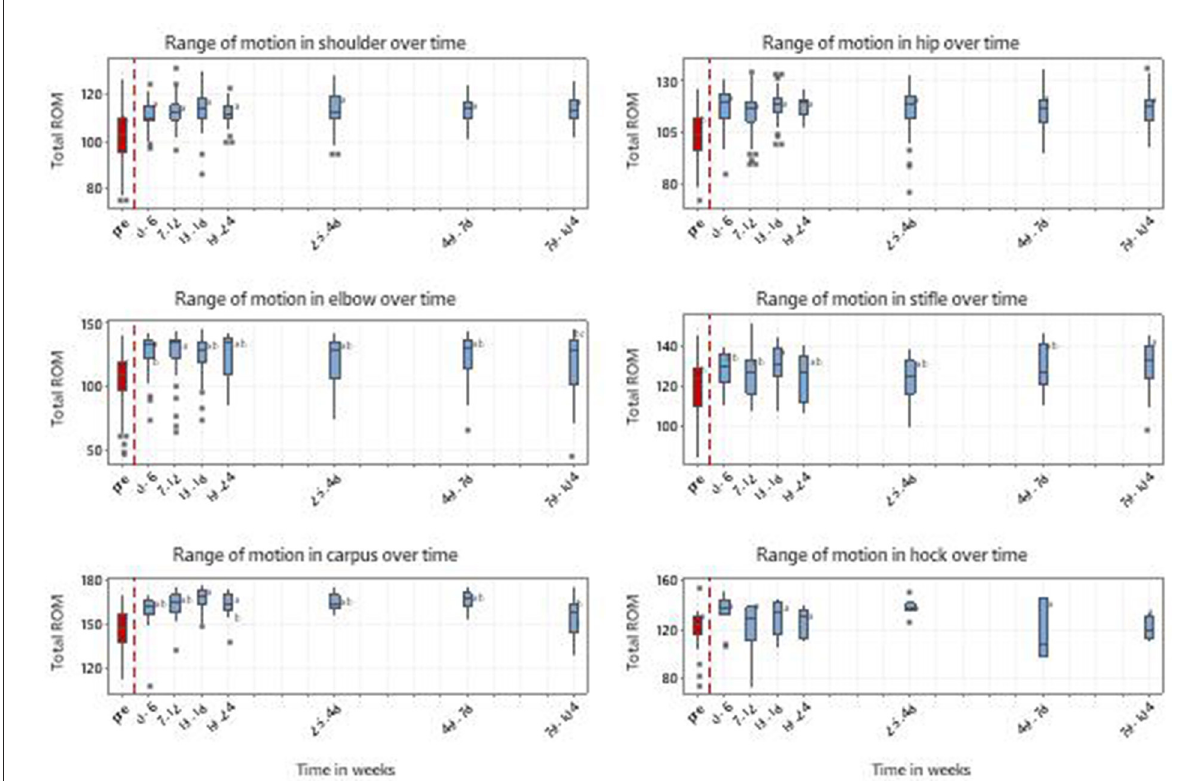
FIGURE7 Range of motion in thoracic and pelvic limbs for 234 dogs with MSD treated with RM in time windows representing pretreatment (pre) and up to 104 weeks post initial treatment. Shoulder n = 191, Elbow n = 123, Carpi n = 51, Hip n = 158, Stifle n = 60 and Hock n = 28. Individual dogs may have received treatment to multiple joints. Letters adjacent to each bar indicate which time windows are significantly different (i.e., those not sharing a common